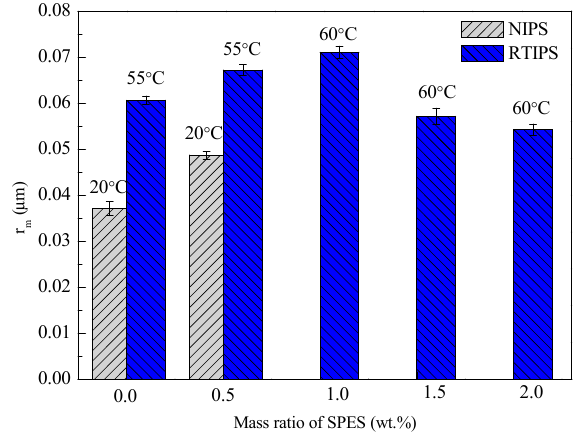
Figure 7. Rejection rate of the prepared PES hollow fiber membranes.